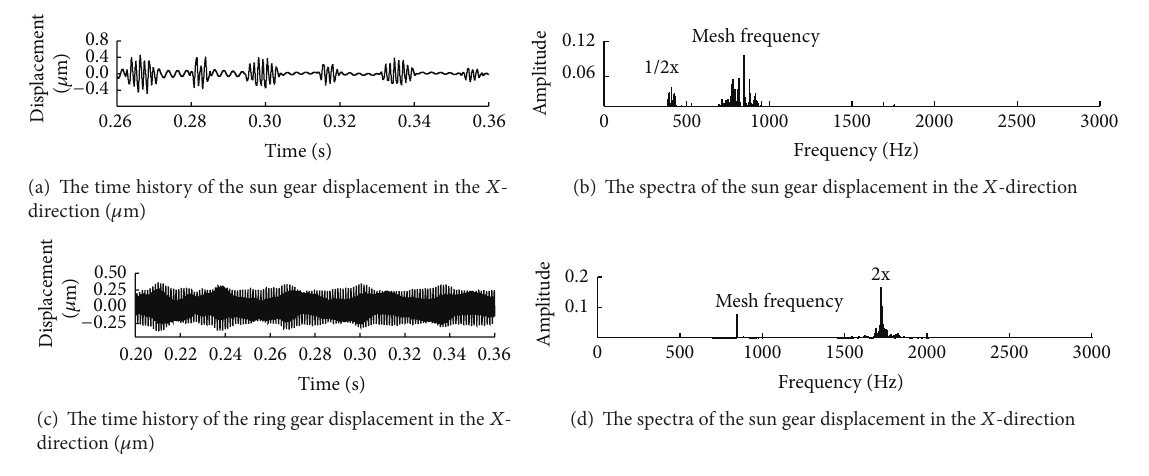
Figure 13: Time history and frequency spectrum for displacement of center gear along 𝑥 direction at 2000